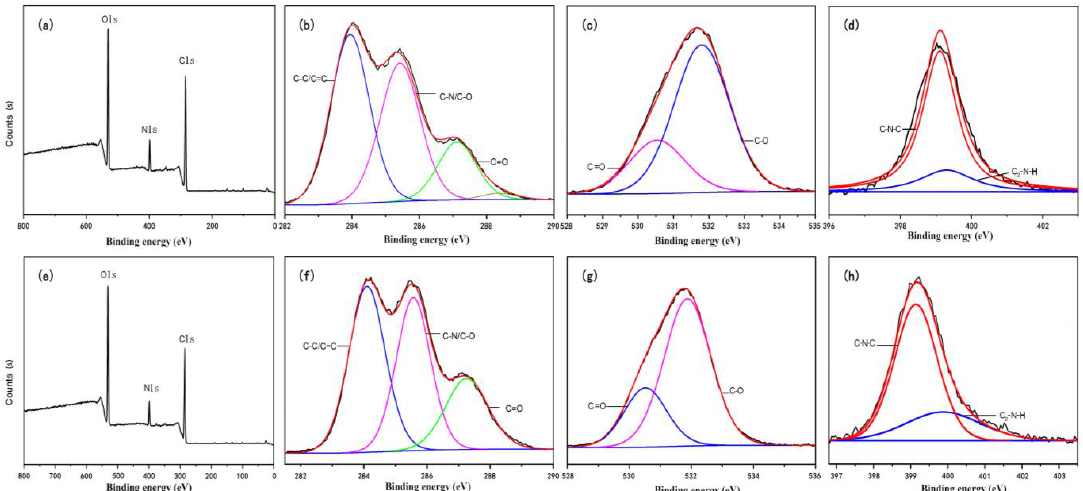
Figure 3. XPS characterizations of N-CQDs. Full spectrum: ( a , e ); Cls: ( b , f ); Ols: ( c , g ); Nls: ( d , h ), represents ON-CQDs and WN-CQDs, respectively.